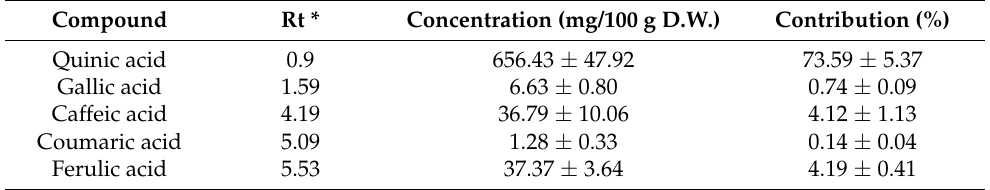
Table 1. Main phenolic compounds present in the hydrophilic extracts of spent coffee grounds. Compound Rt * Concentration (mg/100 g